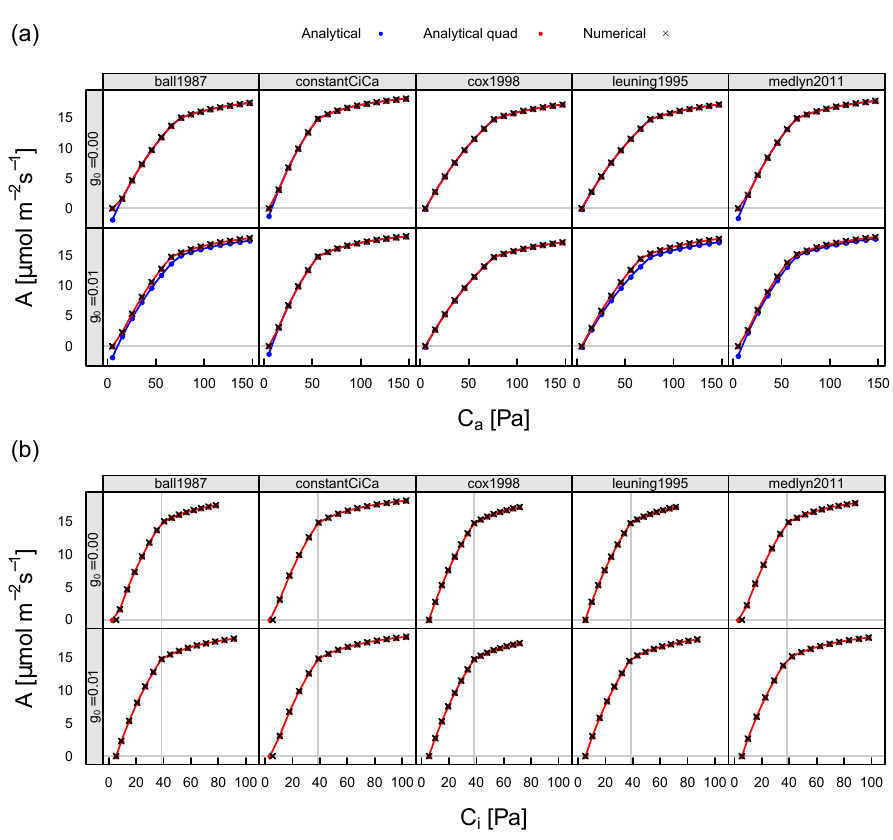
Figure 4. Comparison of carbon assimilation against (a) atmospheric CO 2 ( A - C a ) curves and (b) internal CO 2 ( A - C i ) curves produced by the simple analytical solution (blue points and lines), the quadratic analytical solution (red points and lines), and the numerical so- lution (black crosses) for five different representations of stomatal conductance, Eqs. (A12b)–(A12g), and two values of g 0 (0.00 and 0.01molH 2 Om − 2 s − 1